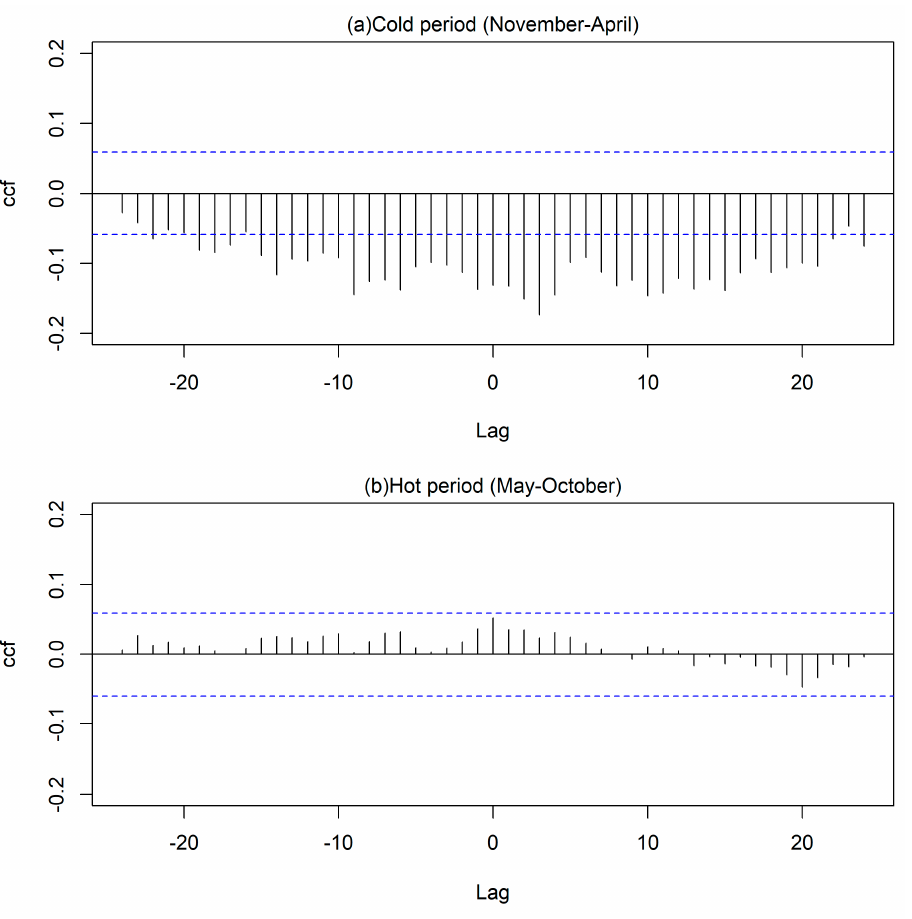
Figure 1. Cross correlation for ( a ) minimum daily temperature (x) and mortality (y) for months November to April; ( b ) Minimum daily temperature (x) and mortality (y) for months May to October). Dotted blue horizontal lines show the 95% significance limits.